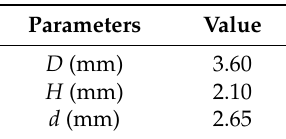
Figure 1. Model of the O-ring: ( a ) solid model; ( b ) part of the area; ( c ) geometric model. Table 1. Parameters of the O-ring.